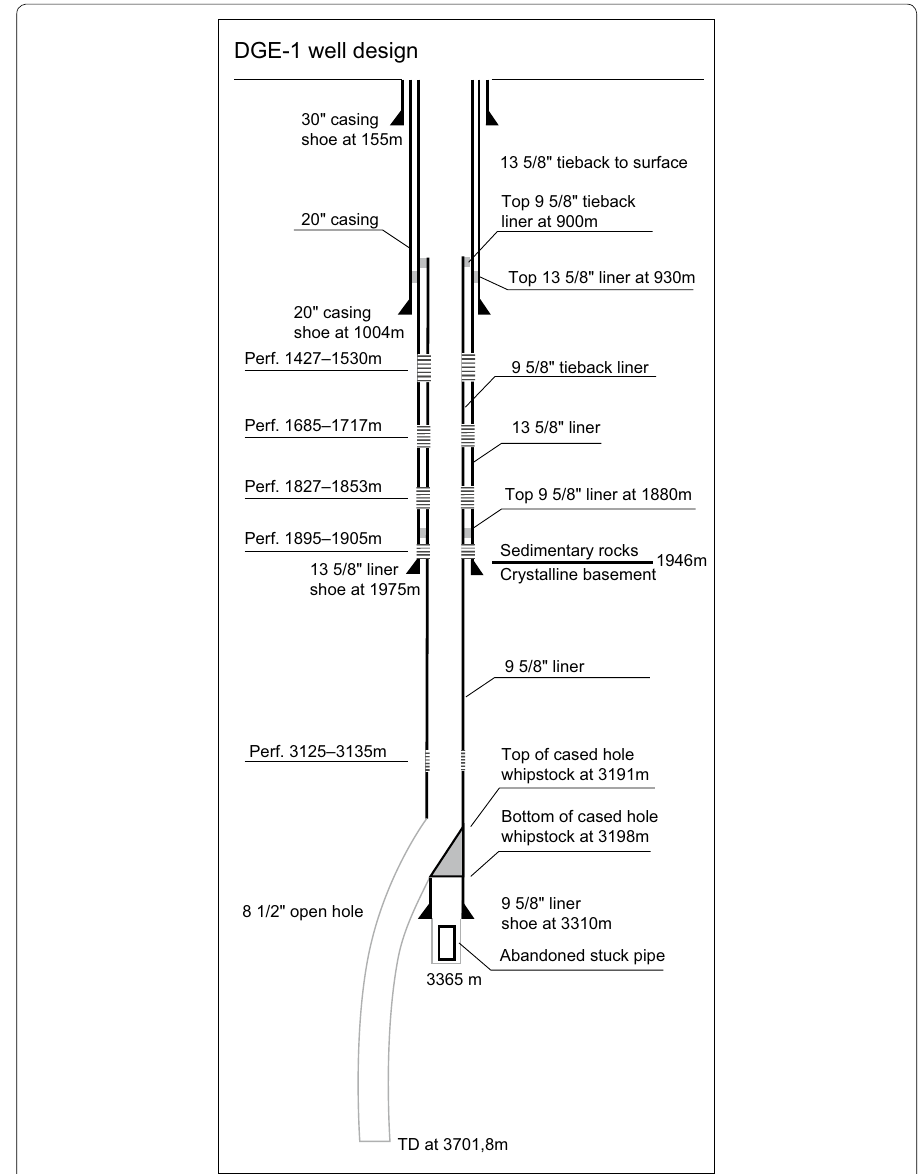
Fig. 5 Illustration of the DGE‑1 well design [Modified from Howard‑Orchard (2003)]. Perforations in the sedimentary succession between 1427 and 1905 m were conducted after the testing and evaluation of